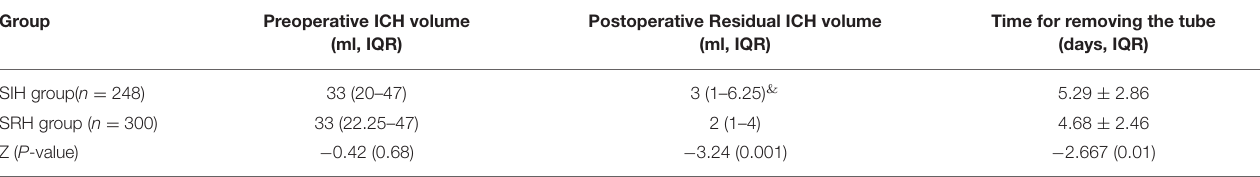
TABLE 2 | Changes in hematoma volume before and three days after surgery. Group